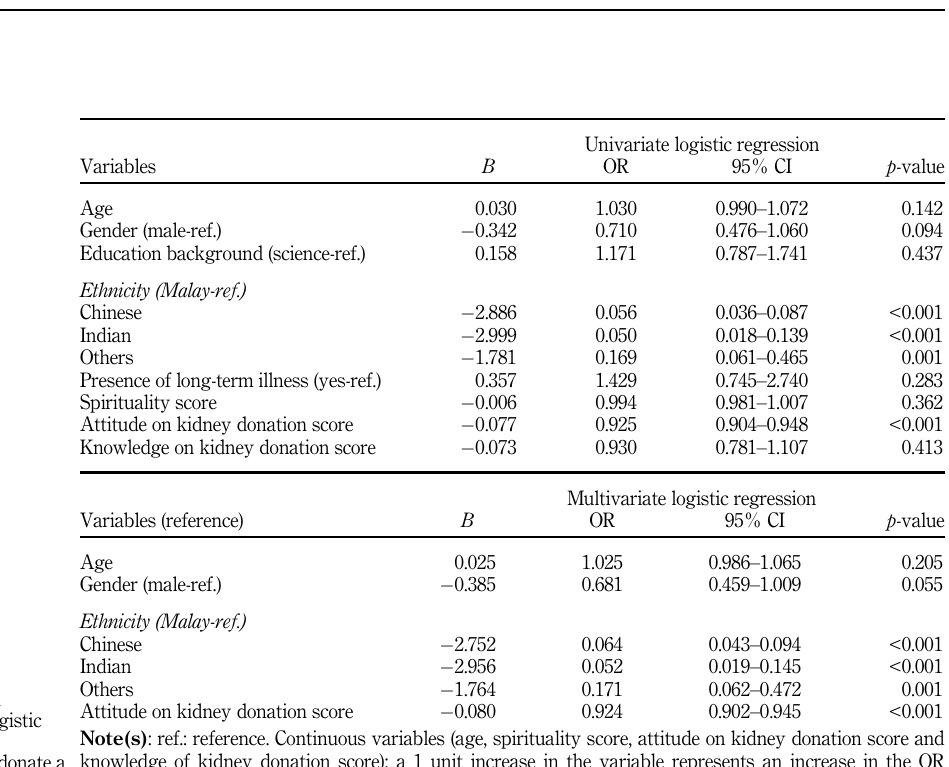
Table 4. Knowledge on kidney donation among study population ( n 5 1,001)